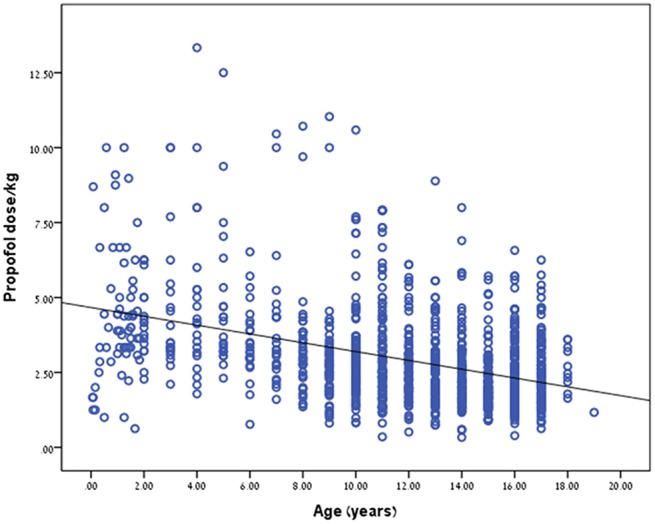
Relation between patient age and propofol dose (mg/kg).